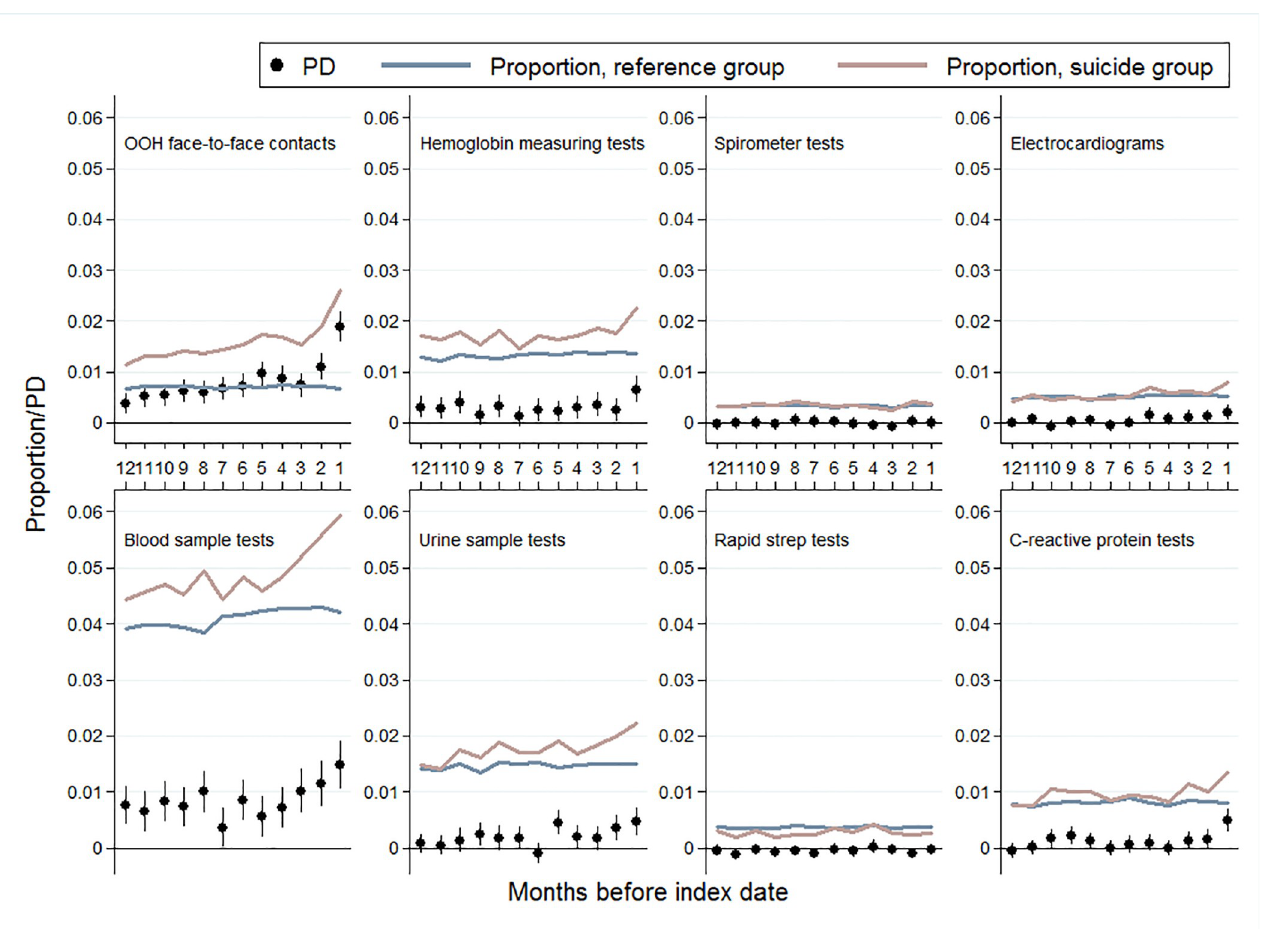
Fig 4. Out-of-hours face-to-face contacts and different types of contacts and tests taken in general practice stratified on months before suicide. All PD estimates are adjusted for age, sex, and calendar period.